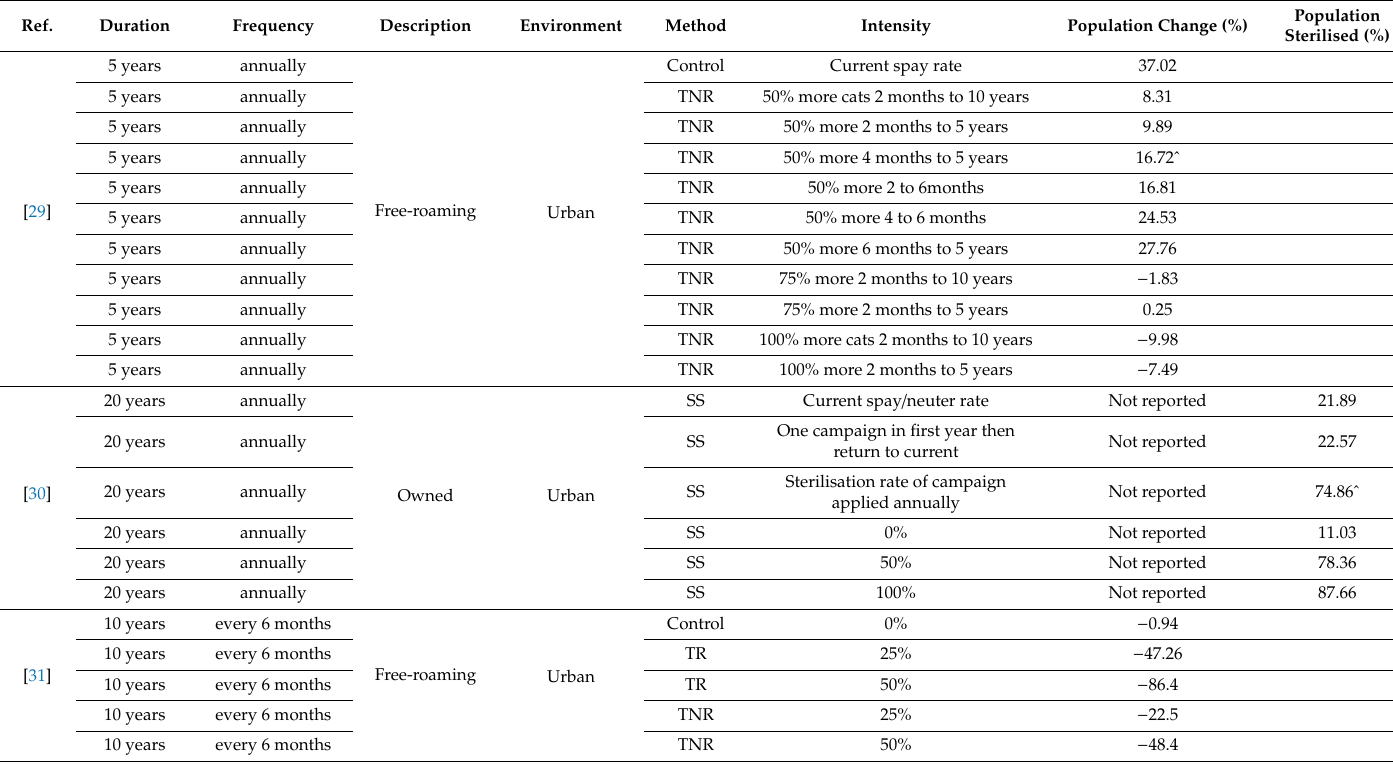
Table 3. Results from five articles where the impact of cat population management strategies were estimated through computer model simulation.